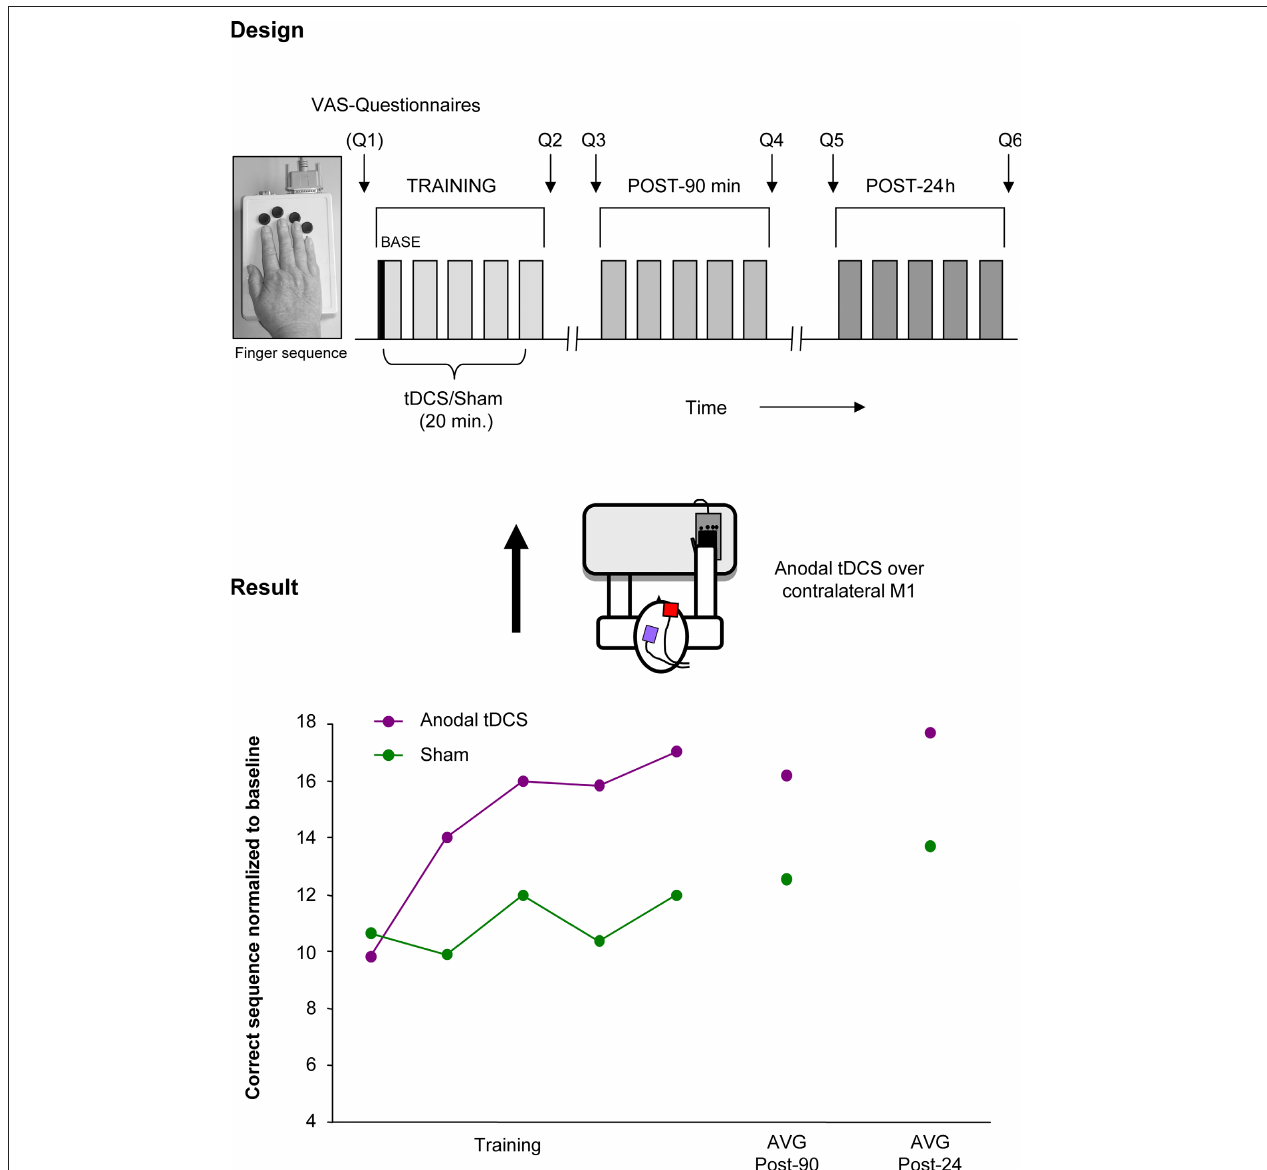
FIGuRe 3 | Improving motor learning by tDCS: single subject data. Performance enhancing effects of tDCS on a motor learning task (single subject data). Design: anodal (facilitatory) tDCS or Sham was applied concurrent with training of a finger sequence, performed with the right. Result: The main finding was that anodal tDCS combined with a motor training enhanced the number